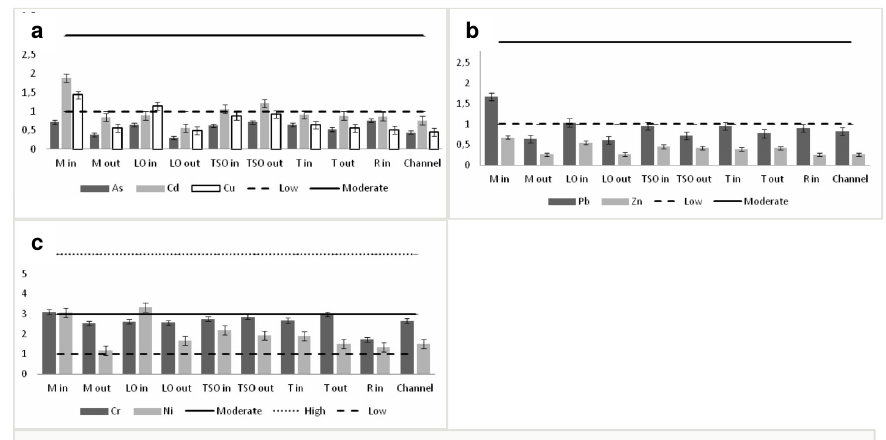
The C index values calculated for each element per station. Abbreviations for stations are the same as described in Fig. 8. The dashed, continuous and dotted lines represent the thresholds for low, moderate and high contamination of the sediment,